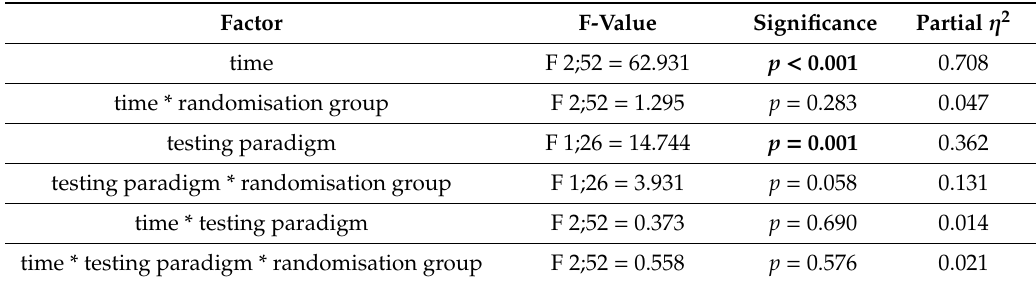
Table 1. Repeated measures ANOVA for PCES-induced and heat pain intensity with within factors “time” (“at baseline”, “during CS”, and “after CS”) and “testing paradigm” (“PCES” and “heat”) and between-subject factor (“randomisation group”). Factor F-Value Significance Partial η 2 time F 2;52 = 62.931